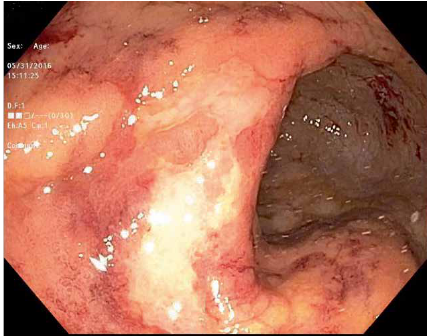
Figure 1: Rectal mucosal with ulcerations.